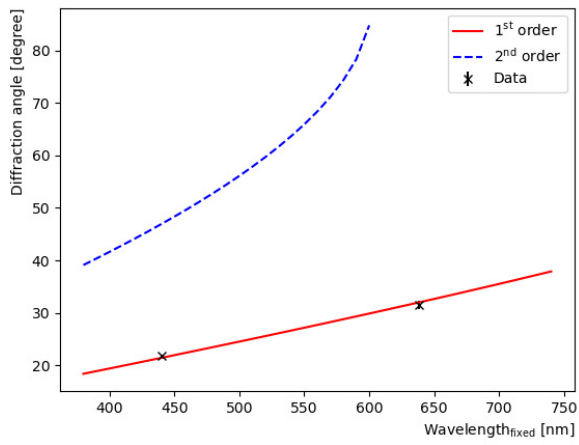
Figure 4. Comparison of the theoretical diffraction fringe position and laser point positions. For the theoretical diffraction curve, only the 1st order and 2nd order are drawn. The dotted line represents the 2nd-order diffraction pattern. In our experiment, only the 1st-order points were investigated.